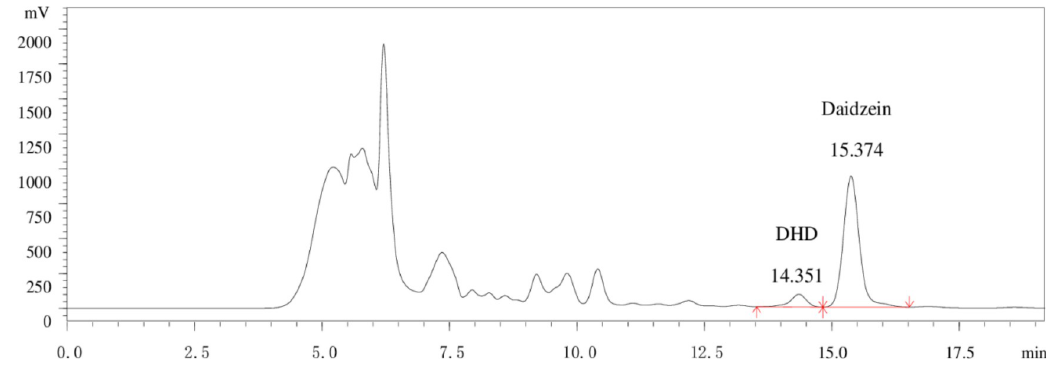
Fig 2. HPLC chromatogram of the culture medium.